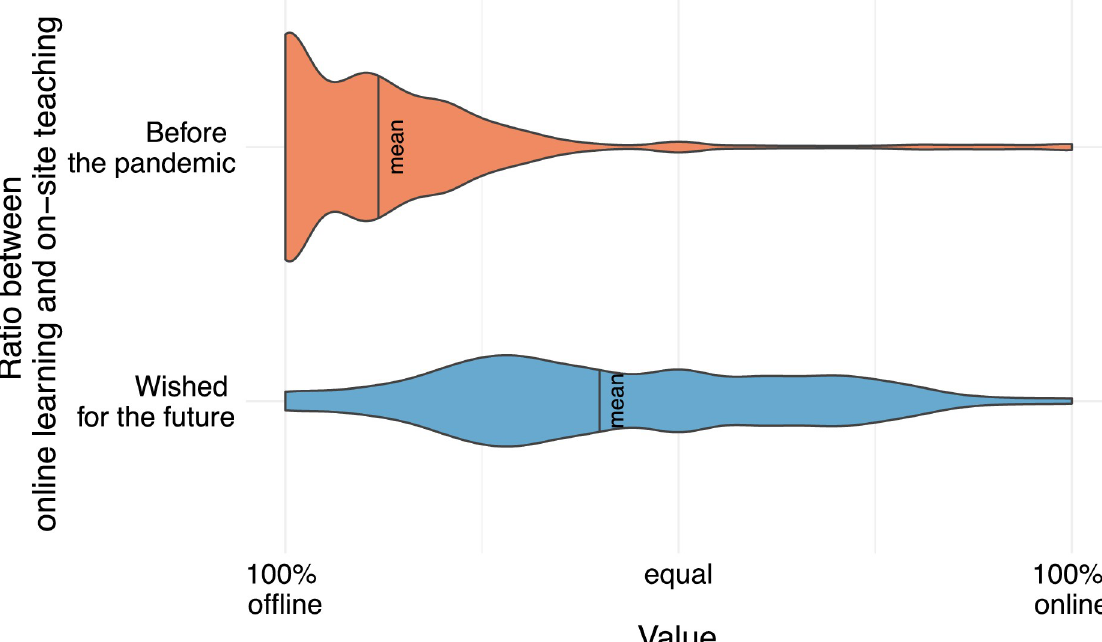
Fig 3. The upper violin plot depicts the ratio between online learning and on-site learning before the pandemic (mean 14%). The lower violin plot depicts the ratio between online learning and on-site learning wished for the future (mean 42%).